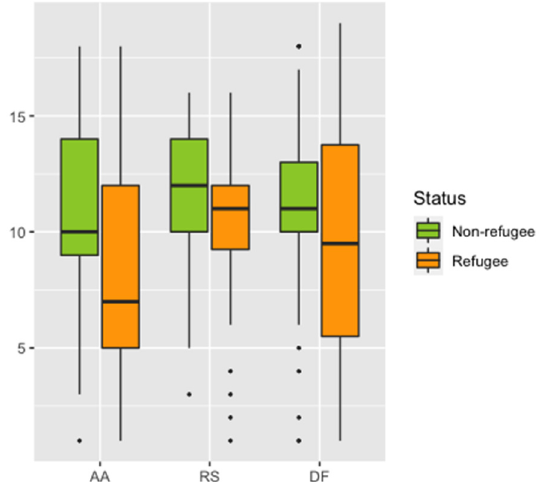
Figure 3. Distribution of refugee and non-refugee children’s scales scores to auditory attention (AA), response set (RS) and design fluency (DF)